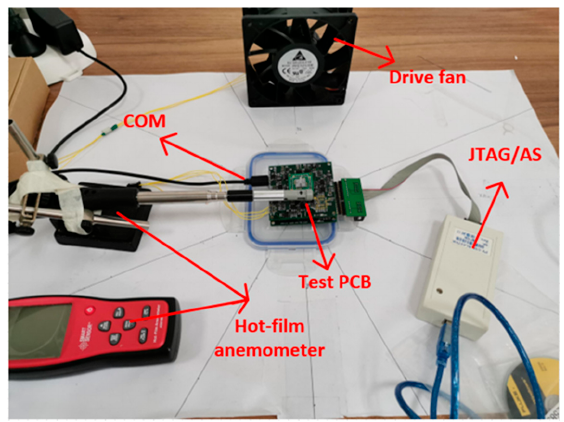
Figure 12. Measurement setup for steady air flow performance evaluation.